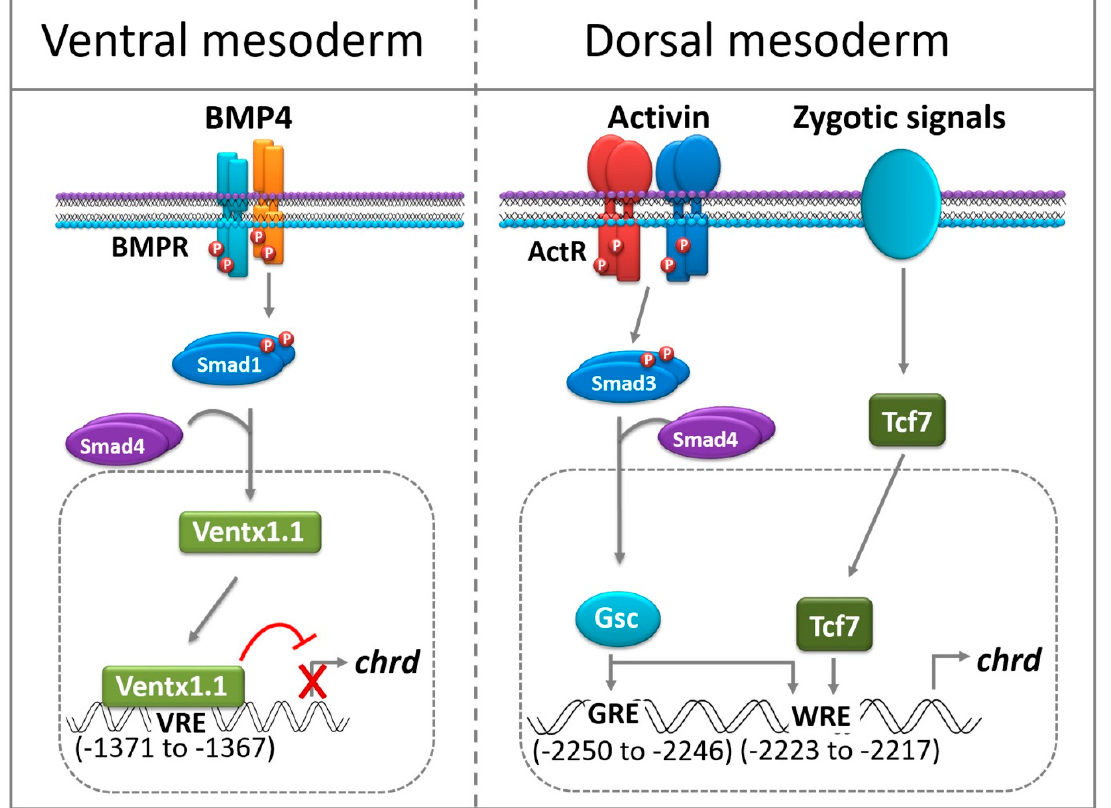
Figure 6. A putative model of Ventx1.1 and Gsc/Tcf7-mediated regulation of chrd transcription. A schematic representation of Ventx1.1-mediated negative regulation of chrd transcription by direct binding to VRE within the chrd promoter region during gastrula for ectoderm specification in Xenopus embryos. Whereas in the organizer (or dorsal mesoderm) region, Gsc interacts with GRE/WRE for activation. Tcf7 specifically binds to the WRE and activates chrd transcription. Supplementary Materials: The following supporting information can be downloaded at: www.mdpi.com/xxx/s1. Figure S1: Serially deleted chrd promoter constructs injected with and without gsc mRNA at the one-cell stage. The relative luciferase activity was measured at stage 11; Figure S2: Identification of GRE1 within the chrd promoter. (A and B) The systematic representation of two targeted point mutations (namely GRE1 and GRE2, shown in the dotted box) was generated by site-directed mutagenesis in the upstream 11 bp (from -2250 to -2239) within the chrd promoter. (C) The mutated chrd(-2250)mGRE1 , chrd(-2250)mGRE2 , and wild-type chrd(-2250) promoter con- structs were then injected with and without gsc mRNA at the one-cell stage. The relative luciferase activity was measured at stage 11. Author Contributions: Conceptualization, V.K. and J.K.; methodology, formal analysis, V.K., Z.U. and J.K.; investigation, V.K.; writing—original draft preparation, V.K.; writing,review and editing, V.K. and J.K.; supervision, J.K. and U.L.; project administration, J.K. and U.L.; funding acquisition, J.K. and U.L. All authors have read and agreed to the published version of the manuscript. Funding: This study was supported by the Basic Science Research Program of the National Research Foundation of Korea (NRF), which is funded by the Ministry of Education, Science, and Technology of Korea (2016R1D1A1B02008770, 2021R1A4A1027355, and 2021M3H9A1097557). Institutional Review Board Statement: This animal study was conducted in accordance with the regulations of the Institutional Animal Care and Use Committee (IACUC) of Hallym University (Hallym 2019-79, 2021-92). Informed Consent Statement: Not applicable.